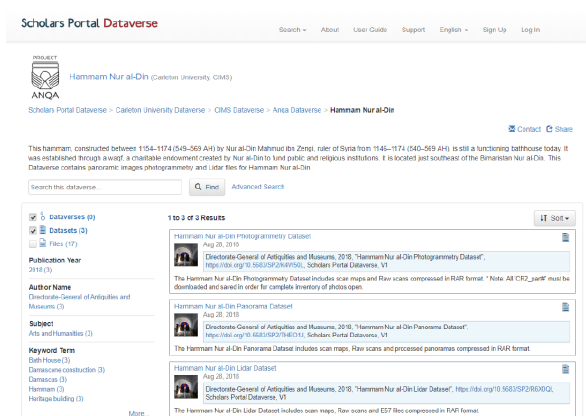
Figure 12 – Dataverse Portal for the Hammam Nur